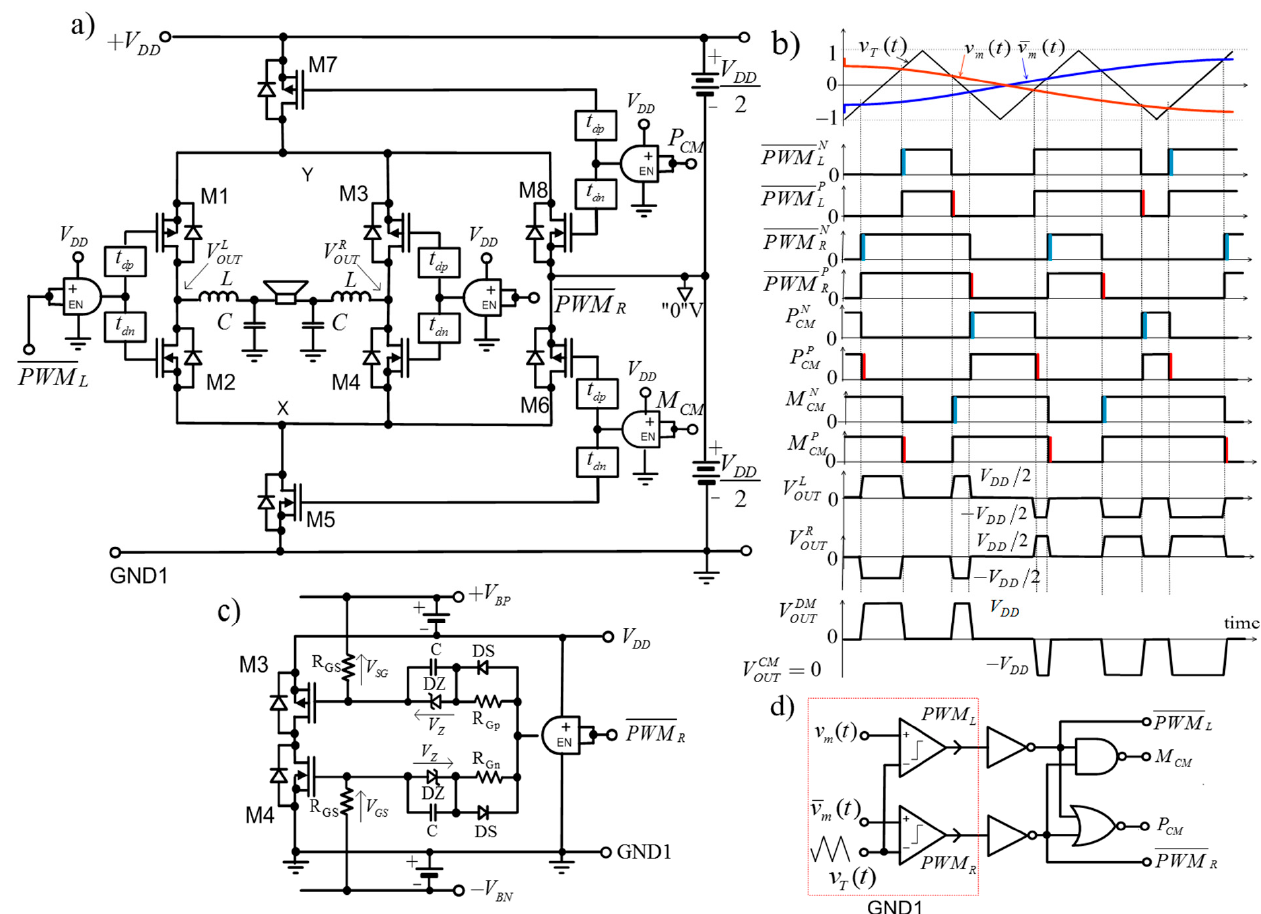
Figure 4. Class-BD audio amplifier with balanced CM output, using the extended NBDD PWM modulator and implemented on complementary MOSFET pairs: ( a ) Topology of the output stage. ( b ) Time domain waveforms at the amplifier outputs, and PWM control signals with delayed turn-on times for the NMOS and PMOS transistors. ( c ) Implementation of the turn-on delay times of the NMOS and PMOS. ( d ) Block diagram of the extended NBDD PWM modulator.